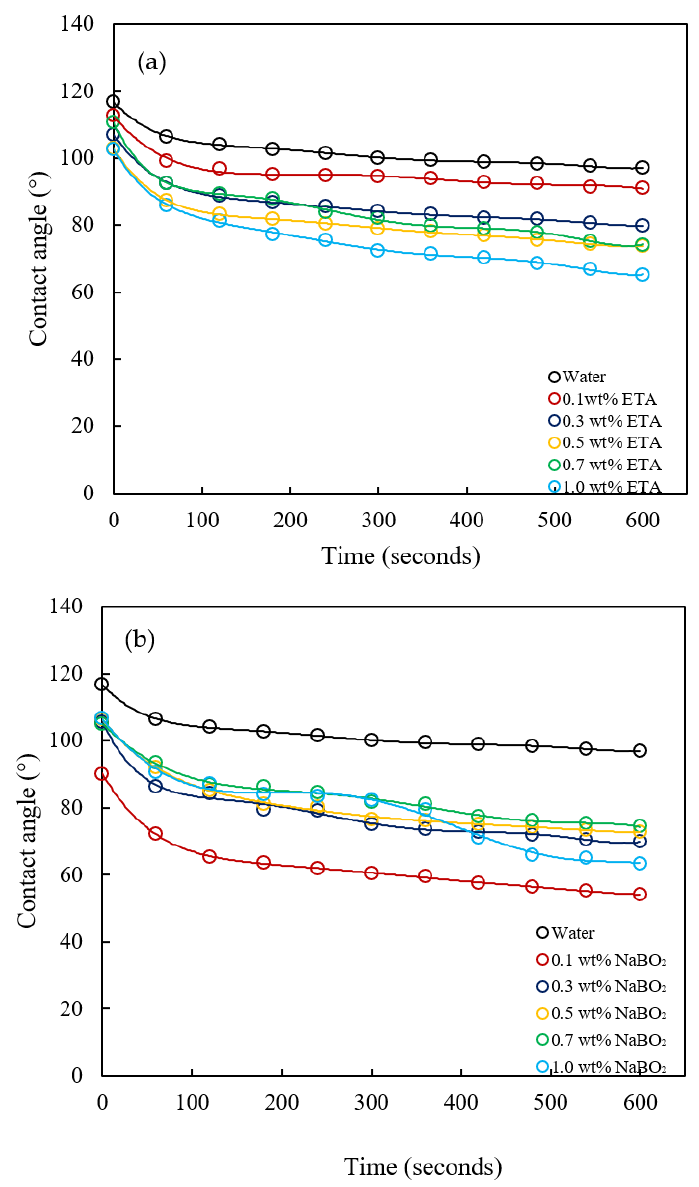
Figure 13. The dynamic contact angle of ( a ) ETA and ( b ) NaBO 2 on a carbonate surface.